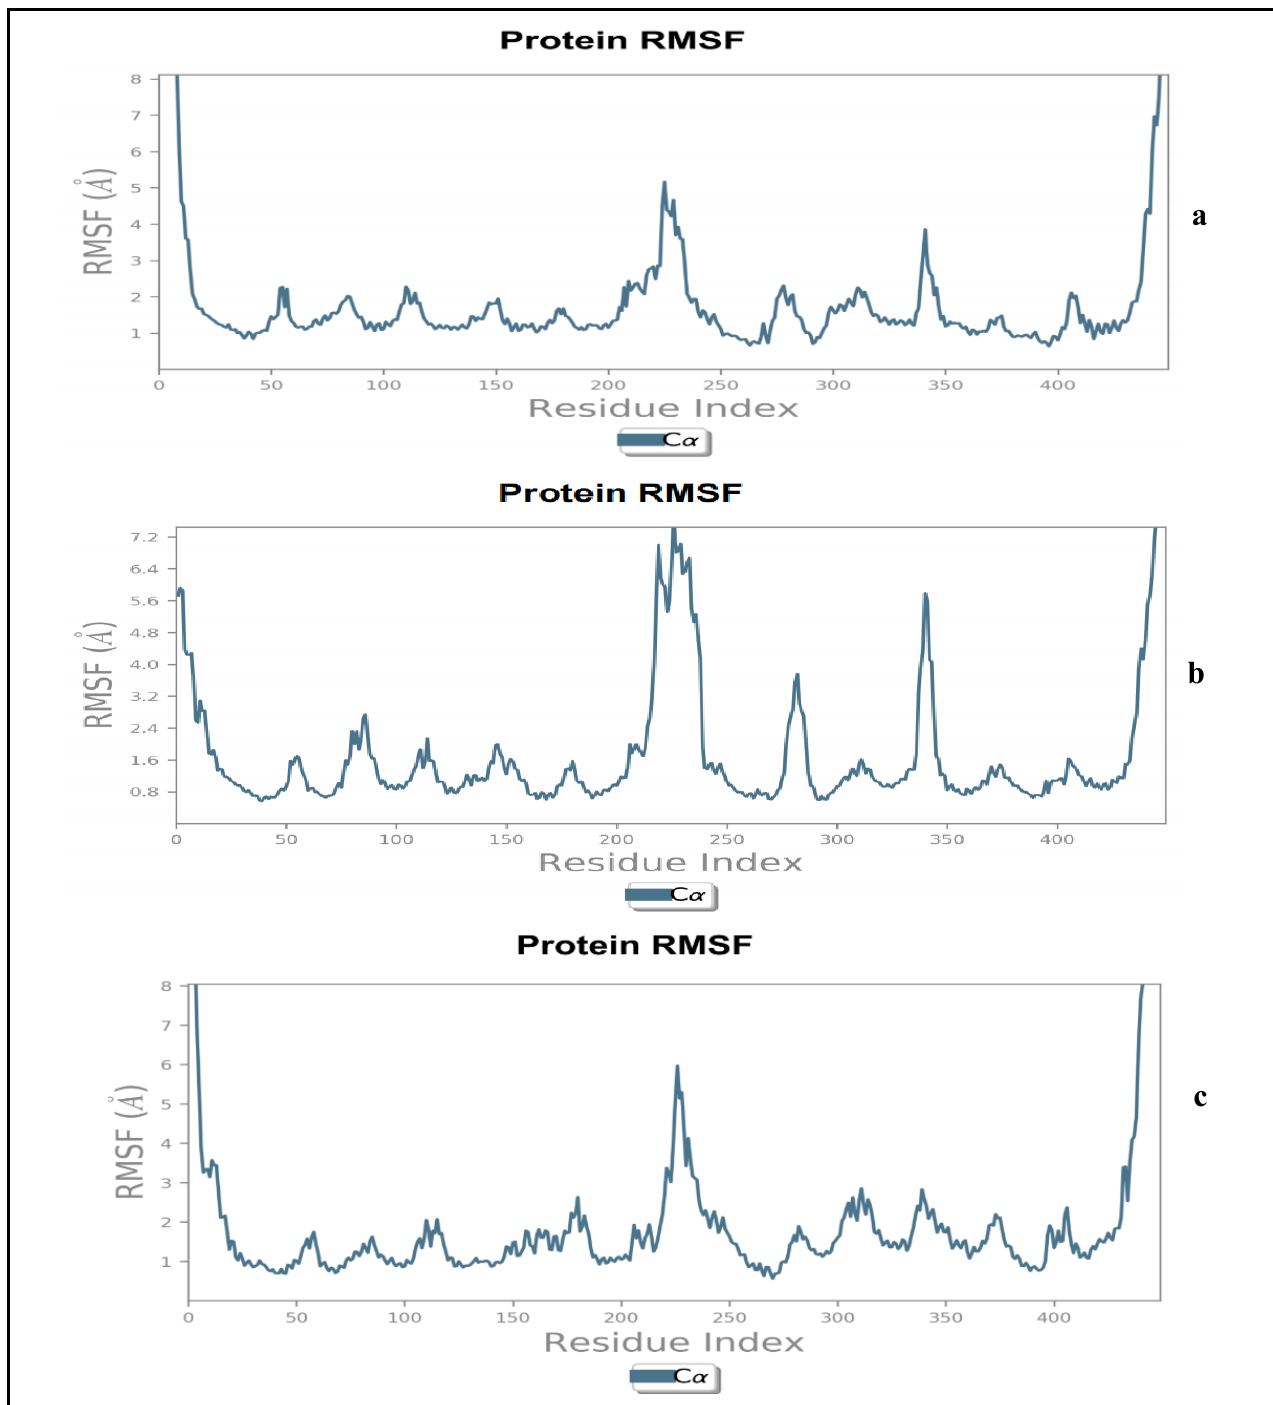
Figure 3. Protein root mean square fluctuation plot for NorA in the presence of ( a ) Sinapic acid, ( b ) p-Coumaric acid, and ( c ) Ciprofloxacin as complexes.